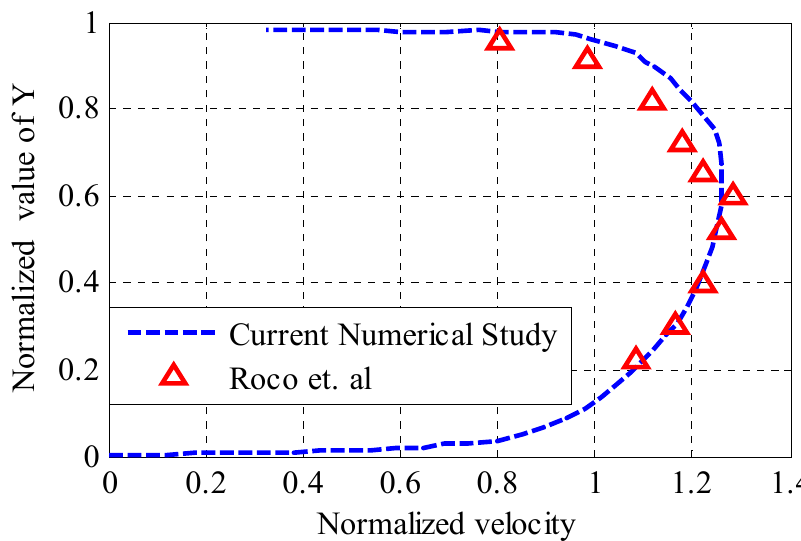
Figure 5. Comparison of experimental and numerical results of the velocity profile.